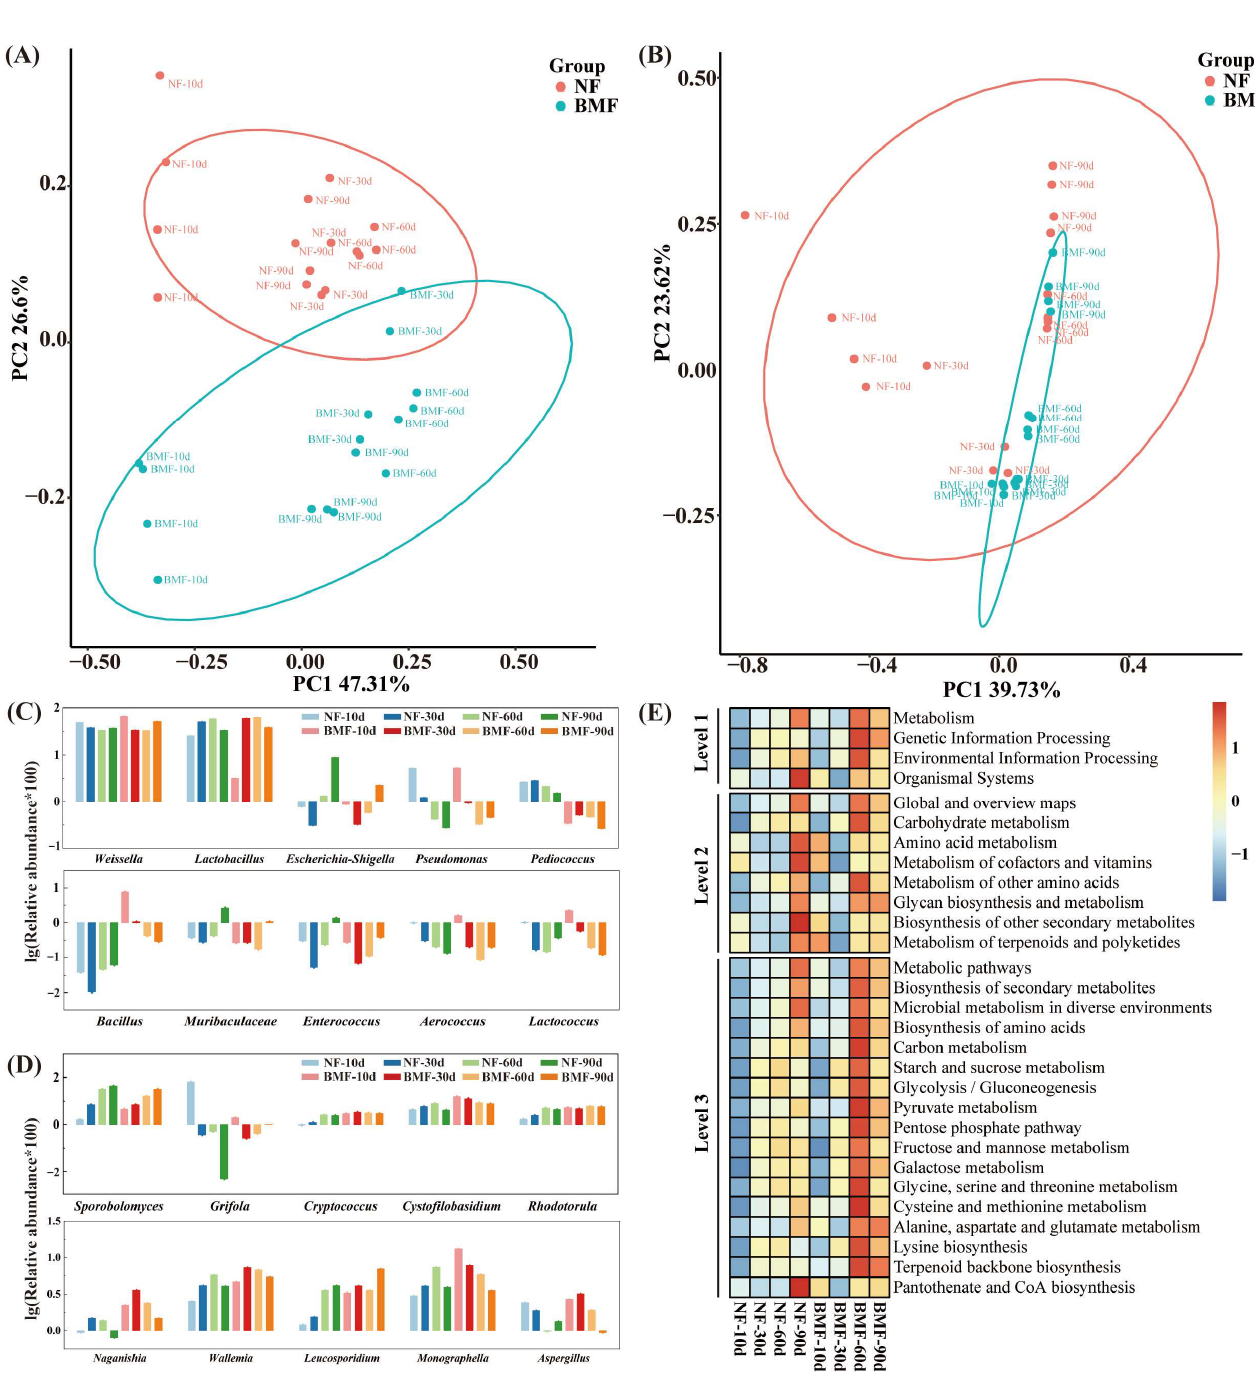
Figure 5. The analysis of dynamic changes in microbial communities between NF and BMF on days 10, 30, 60, and 90 of fermentation. ( A ) PCoA analysis of the bacterial communities based on the Bray-Curtis distance. ( B ) PCoA analysis of the fungal communities based on the Bray-Curtis distance. ( C ) Boxplots of differential bacteria with their abundance between NF and BMF. ( D ) Boxplots of differential fungi with their abundance between NF and BMF. ( E ) The heatmap of predictive functions of bacterial community in NF and BMF.